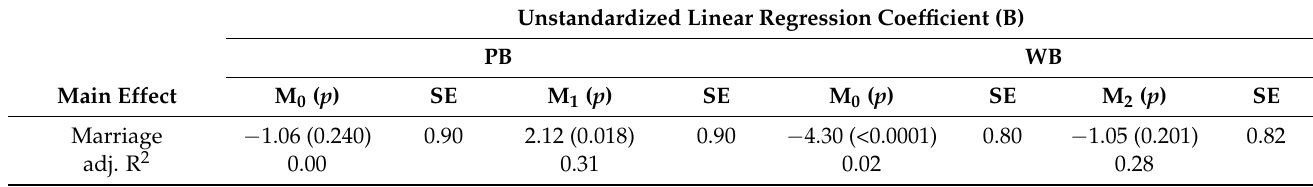
Table 5. Effect of Marriage on Burnout in the Presence or Absence of Confounders.